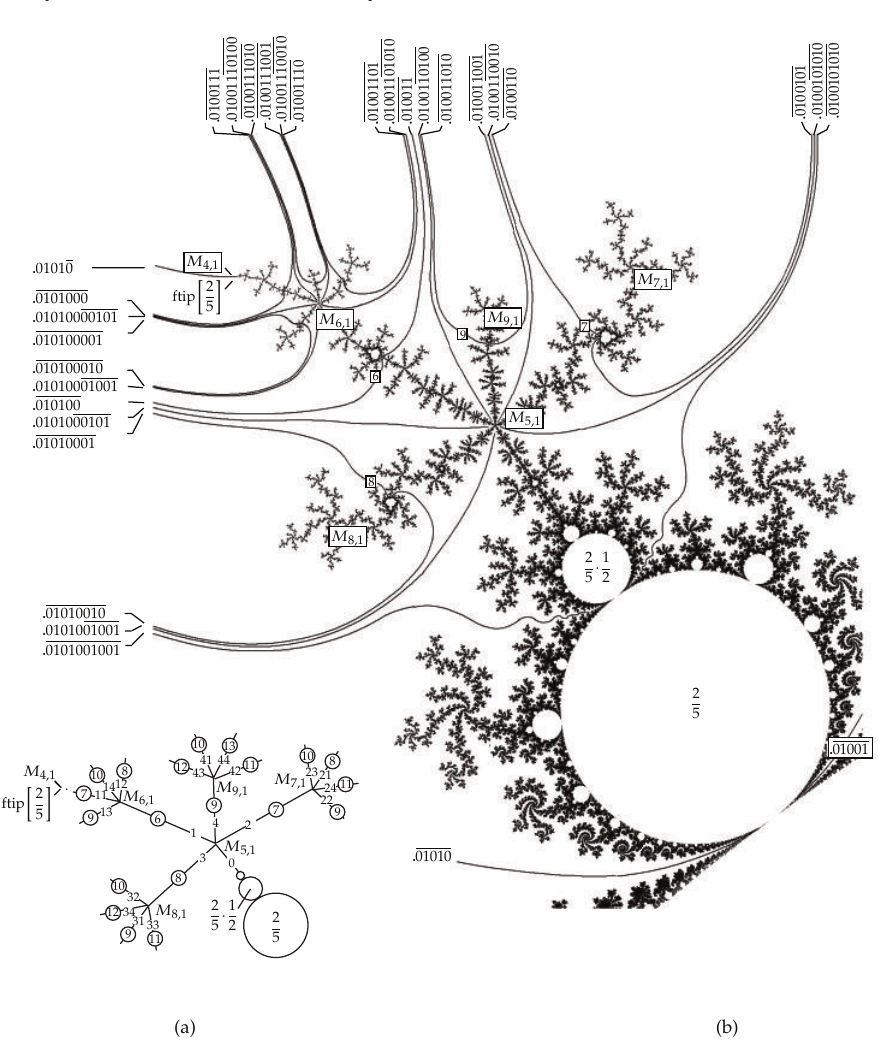
Figure 5: (cid:5) a (cid:6) Sketch of shrub (cid:5) 2 / 5 (cid:6) . (cid:5) b (cid:6) Magnification of the rectangle a of Figure 4, corresponding to shrub (cid:5) 2 / 5 (cid:6)